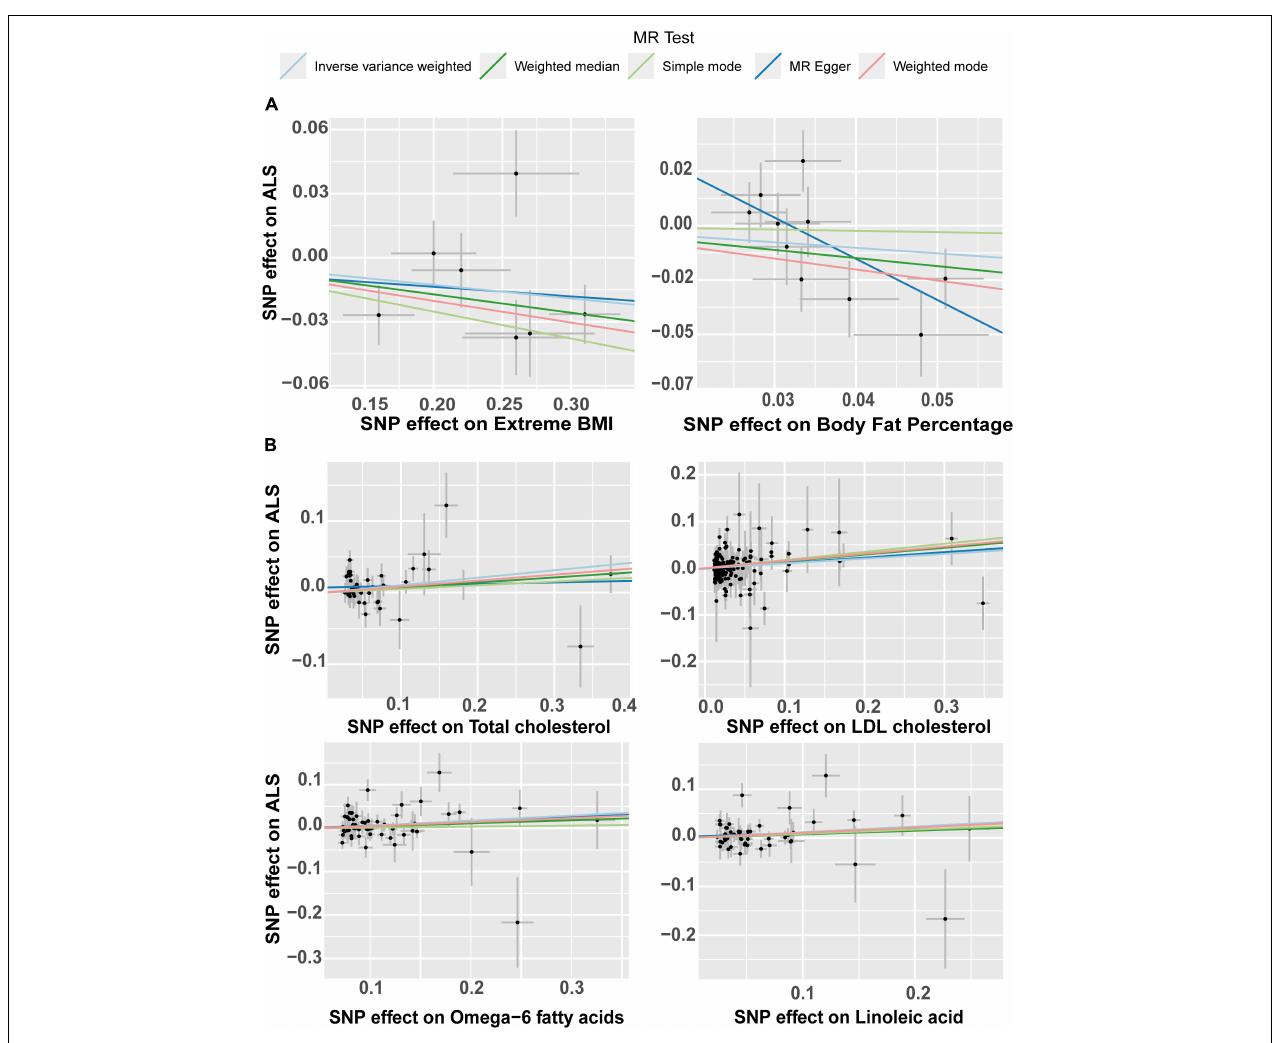
FIGURE 6 | Scatter plot of single nucleotide polymorphism (SNP) potential effects on body lipid metabolic traits vs. amyotrophic lateral sclerosis (ALS). The slope of each line corresponds to the estimated Mendelian randomization (MR) effect per method. (A) Scatter plots show the comparison of the SNPs effects on extreme BMI (body mass index) and body fat percentage (BF%) vs. ALS . (B) Scatterplots of single nucleotide polymorphism (SNP) potential effects on total cholesterol, LDL cholesterol, Omega-6 fatty acid and linoleic fatty acid, vs. amyotrophic lateral sclerosis (ALS). LDL, low density